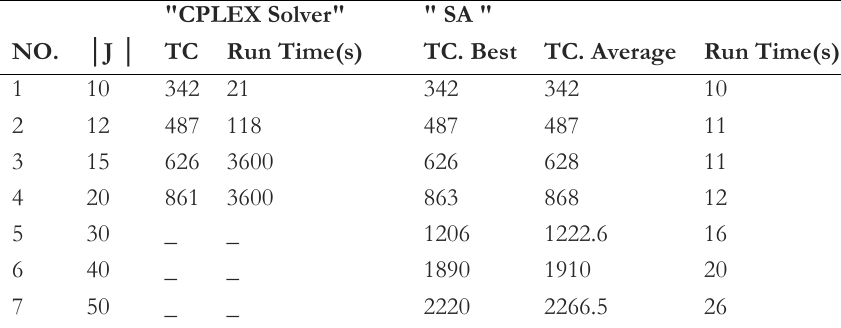
Table 8. Comparison of the results of the SA algorithm and CPLEX